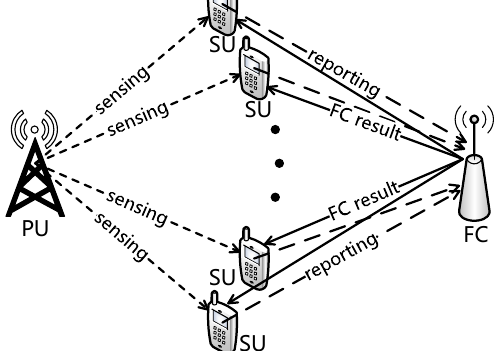
Figure 1. Network model.